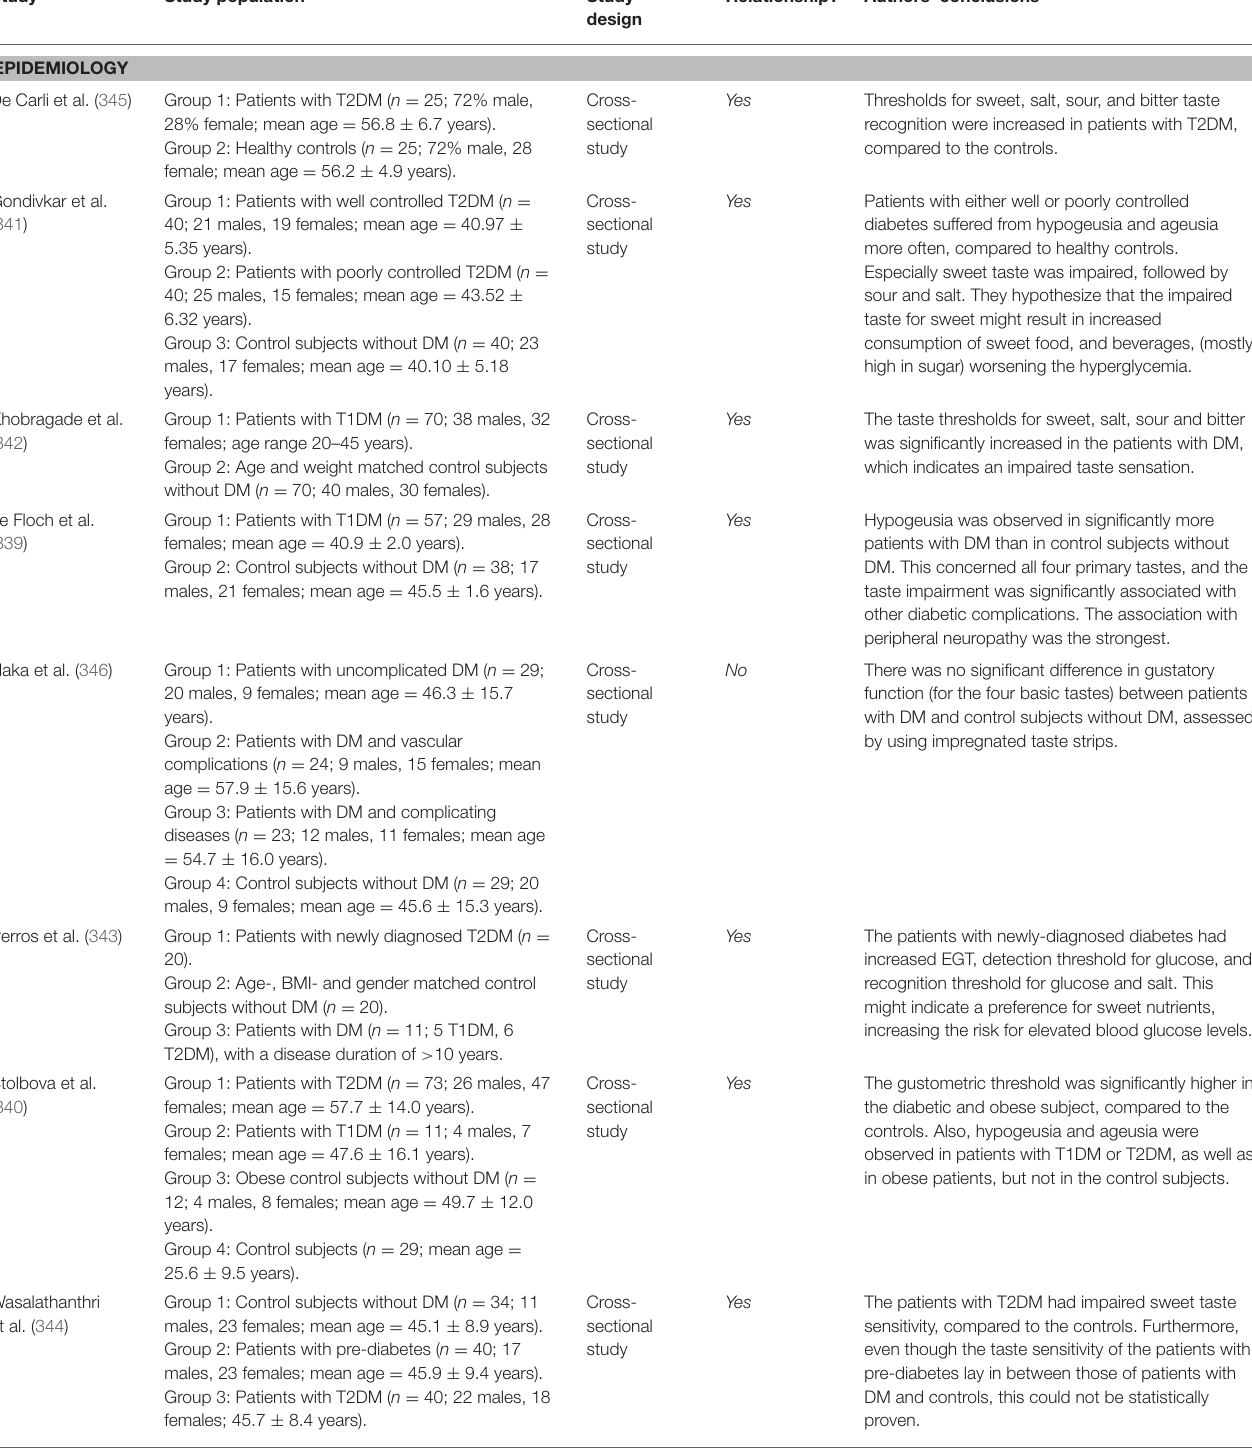
TABLE 7 | Overview of studies investigating the association between diabetes mellitus and taste impairment. Study Study population Study